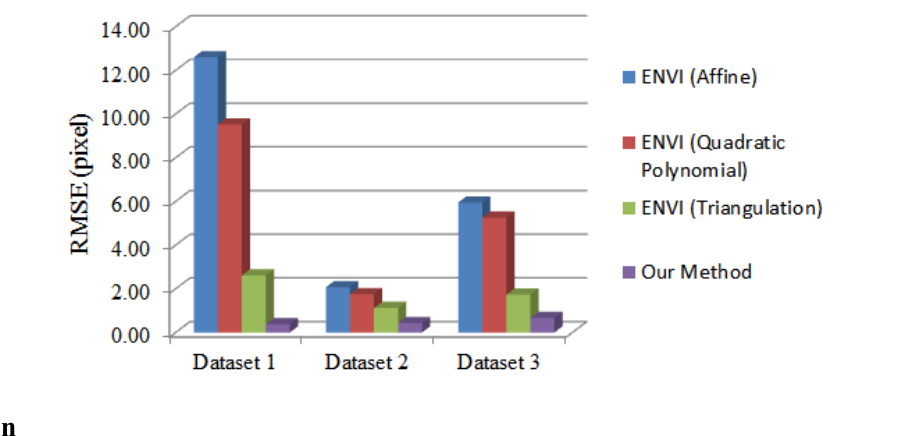
Figure 13. Comparison of registration